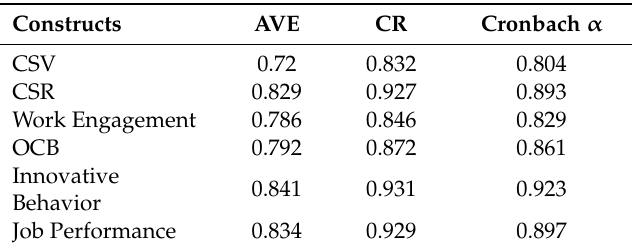
Table 4. Results of convergent